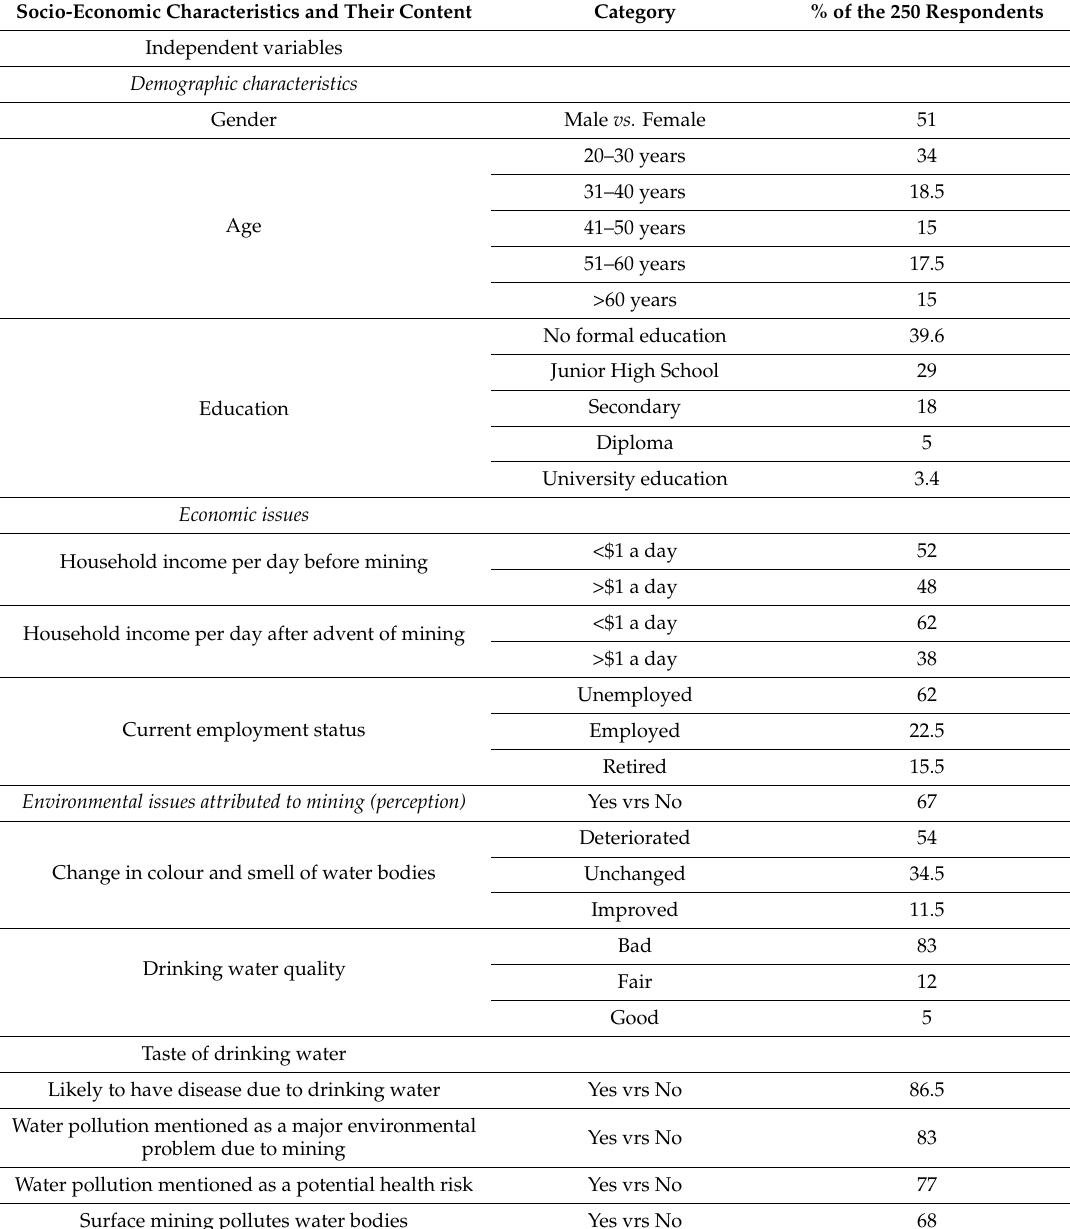
Table 1. Socioeconomic and environmental variables of the perception study, showing questions asked and answers provided by the 250